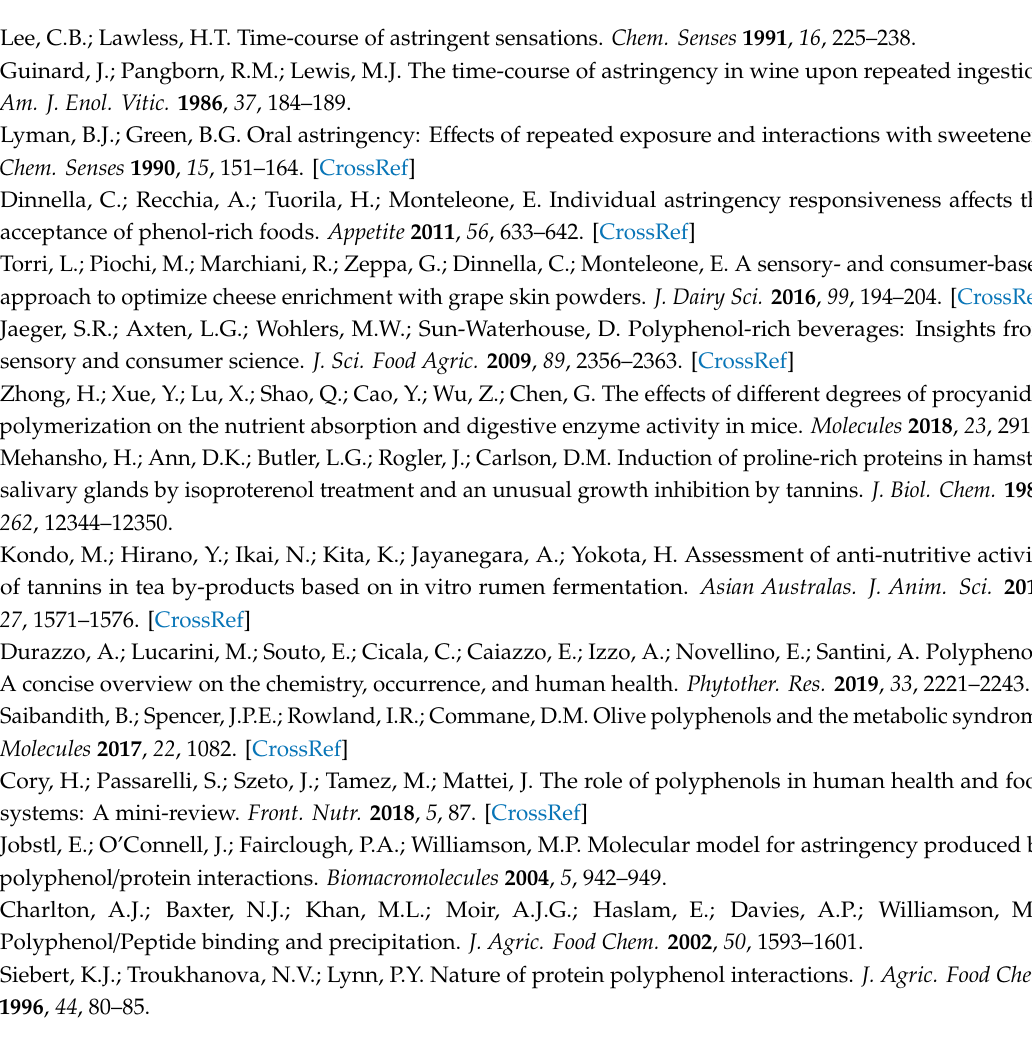
Table S1: List of salivary proteins and peptides quantified by HPLC-low